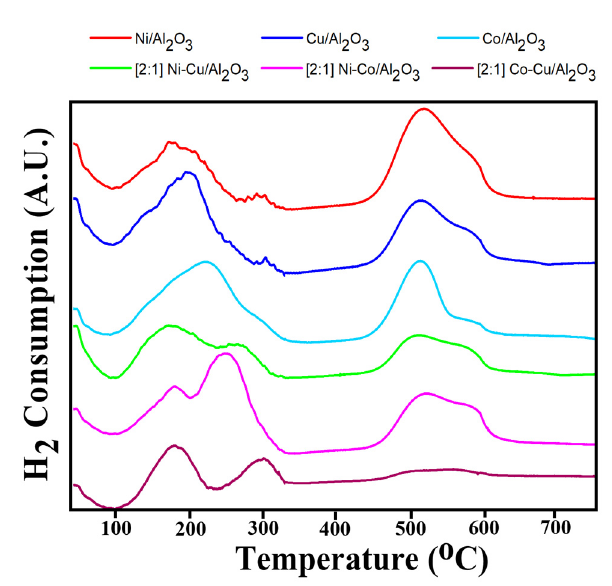
Figure 3. TPR patterns of calcined monometallic and bimetallic catalysts.